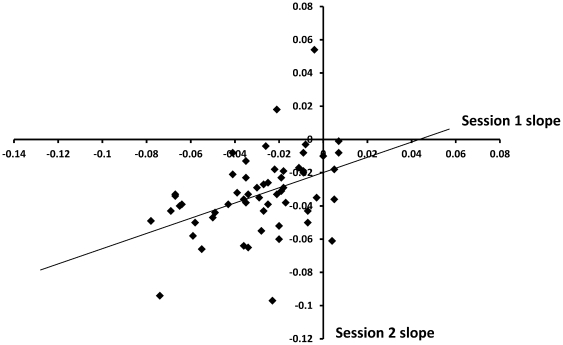
Inter-session reliability of time-on-task slope.Time-on-task slope is significantly correlated across two test sessions spaced one week apart (ICC1,1 = .54, p<.01). Subjects show a tendency to perform slightly worse in the second session.